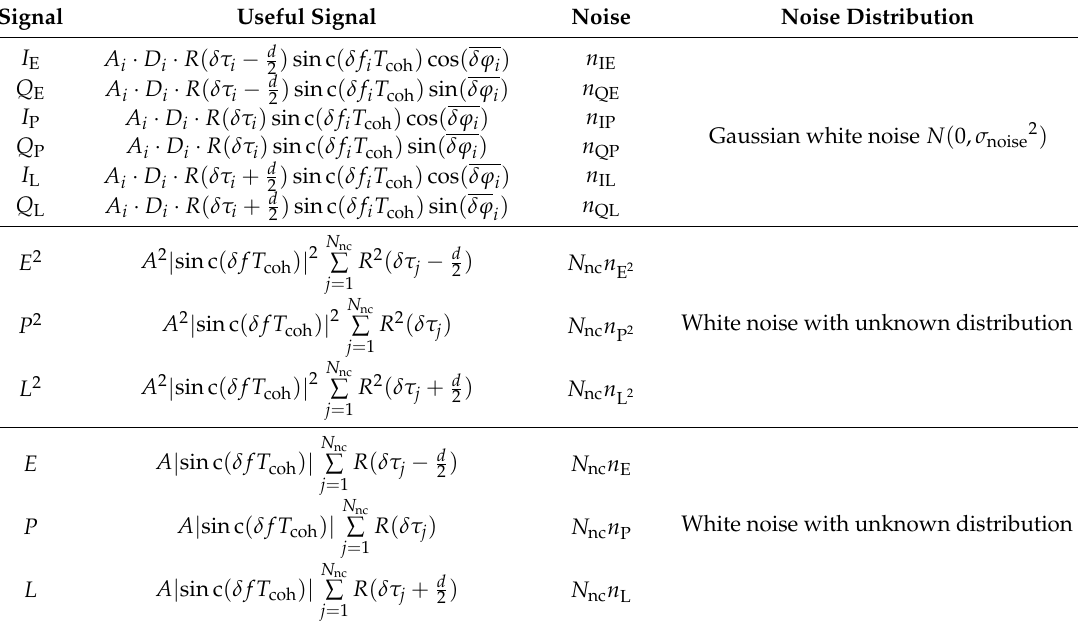
Table 1. The mathematical model of coherent/non-coherent integration